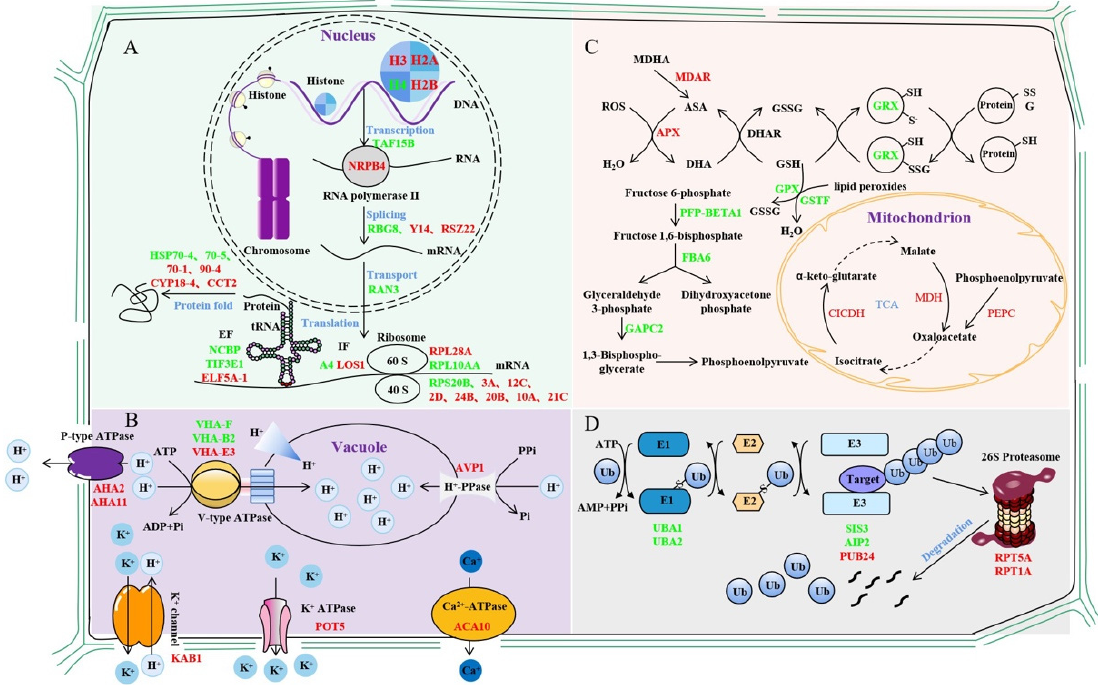
Figure 6. Mechanisms of ubiquitinated protein changes in sugar beet roots under different concentra- tions of salt stress. ( A ). Mechanism of transcriptional and translational regulation of ubiquitination in sugar beet M14 line in response salt stress. ( B ). Mechanism of signal transduction regulation of ubiquitination in sugar beet M14 line in response salt stress. ( C ). Mechanism of metabolism pathway regulation of ubiquitination in sugar beet M14 line in response salt stress. ( D ). Mechanism of UPS regulation of ubiquitination in sugar beet M14 line in response salt stress. Red represents increased ubiquitinated proteins, and green represents decreased ubiquitinated proteins.